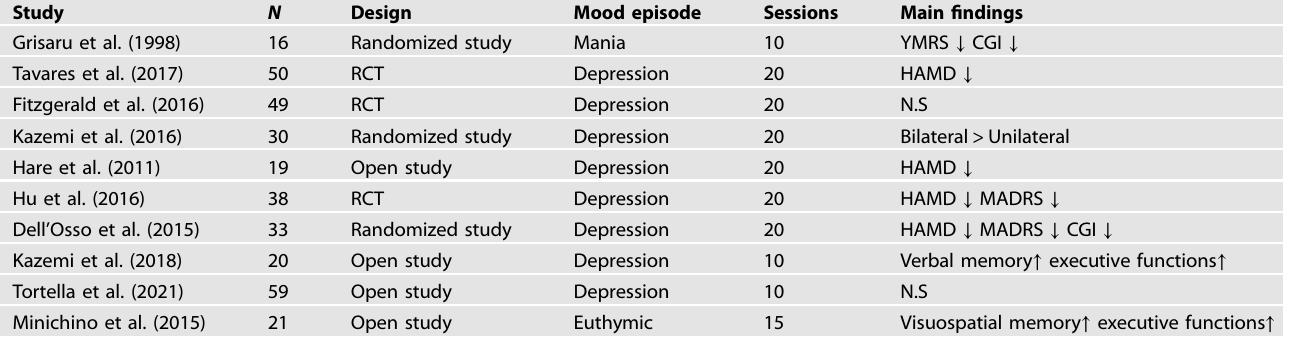
Table 2. Summary of rTMS and tDCS clinical trials in bipolar disorder.